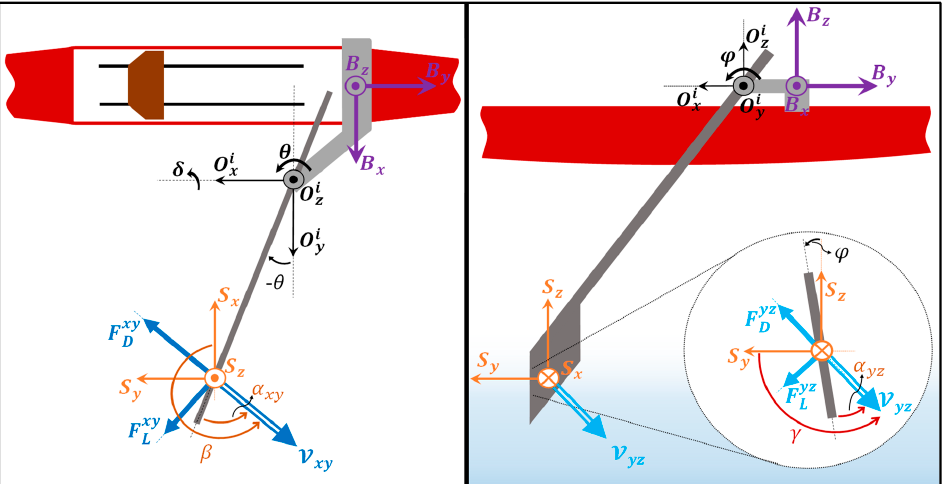
Figure 3. Coordinate systems and forces acting on the oar blade in the LIAC (linear blade immersion, adjusted drag/lift coefficients) model. Blade forces on the horizontal plane are shown in the left pane (top view). Blade forces on the vertical plane are shown in the right pane (side view of the boat). In the right pane, the enlarged circle shows the cross-section of the blade.